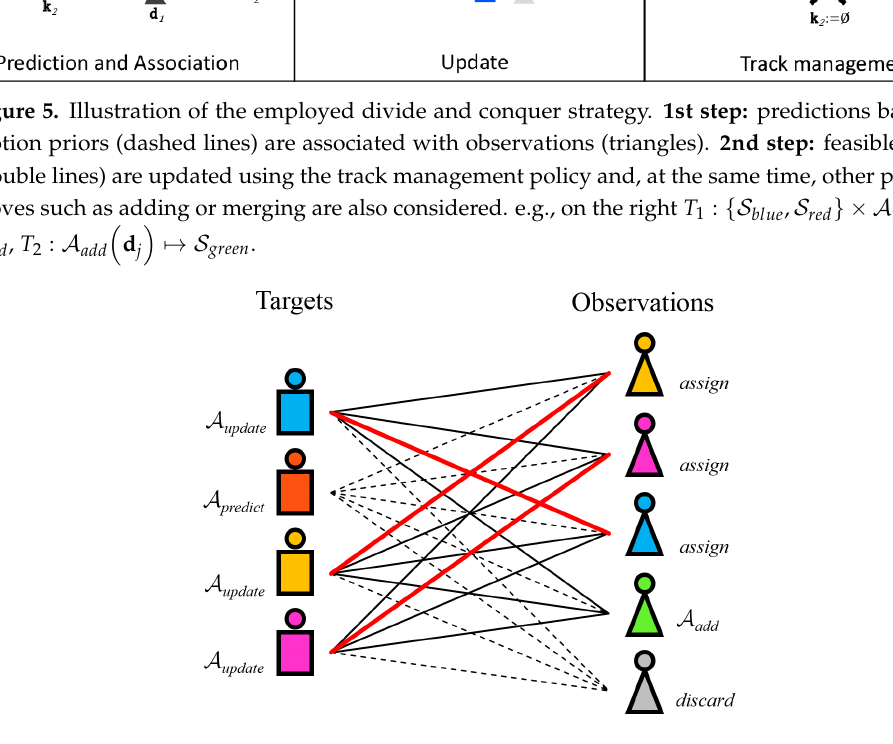
Figure 6. An example association graph between four targets and five detections. Optimal associations are shown as red edges, while the infeasible ones are dashed. One target can not be matched to any detection, and two detections can not be matched to any target. The respective actions taken by the tracker are presented next to each